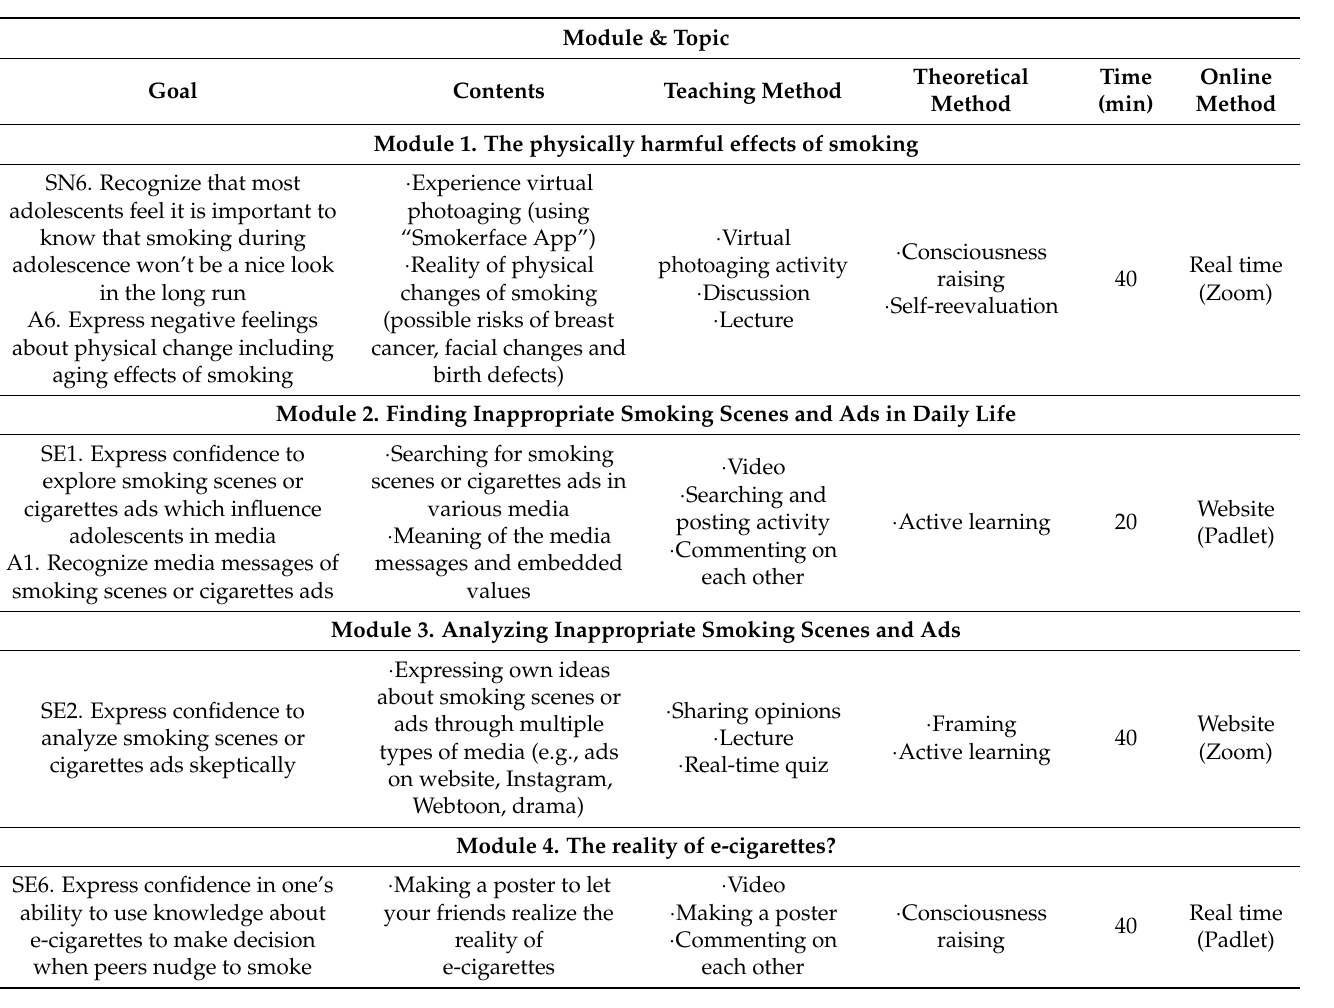
Table 3. Final online media literacy-based smoking prevention program for female